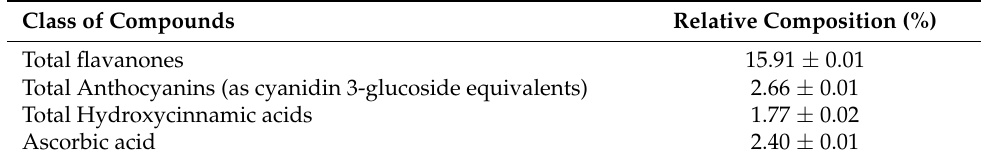
Table 1. Chemical composition of red orange and lemon extract (RLE) used as food supplement for the